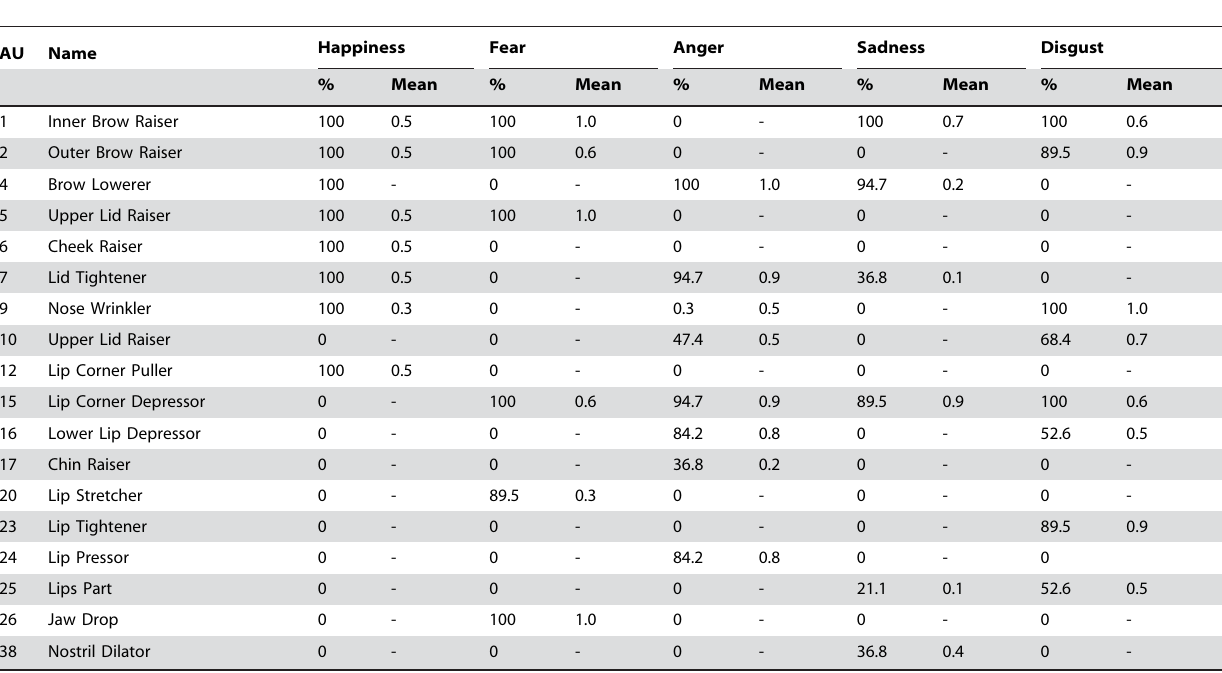
Table 4. FACS of virtual emotions: percentage of faces with respective AU present and mean